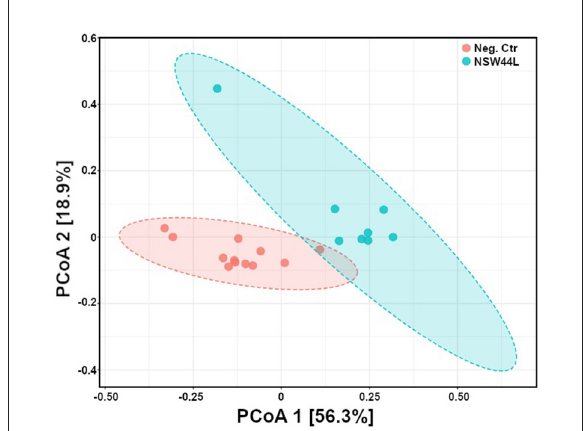
FIGURE2 Principal coordinates analysis (PCoA) of gut microbiota composition of C. hepaticus challenged groups compared with non-challenged birds (at phylum level). The group challenged with the NSW44L strain was clustered away from the control